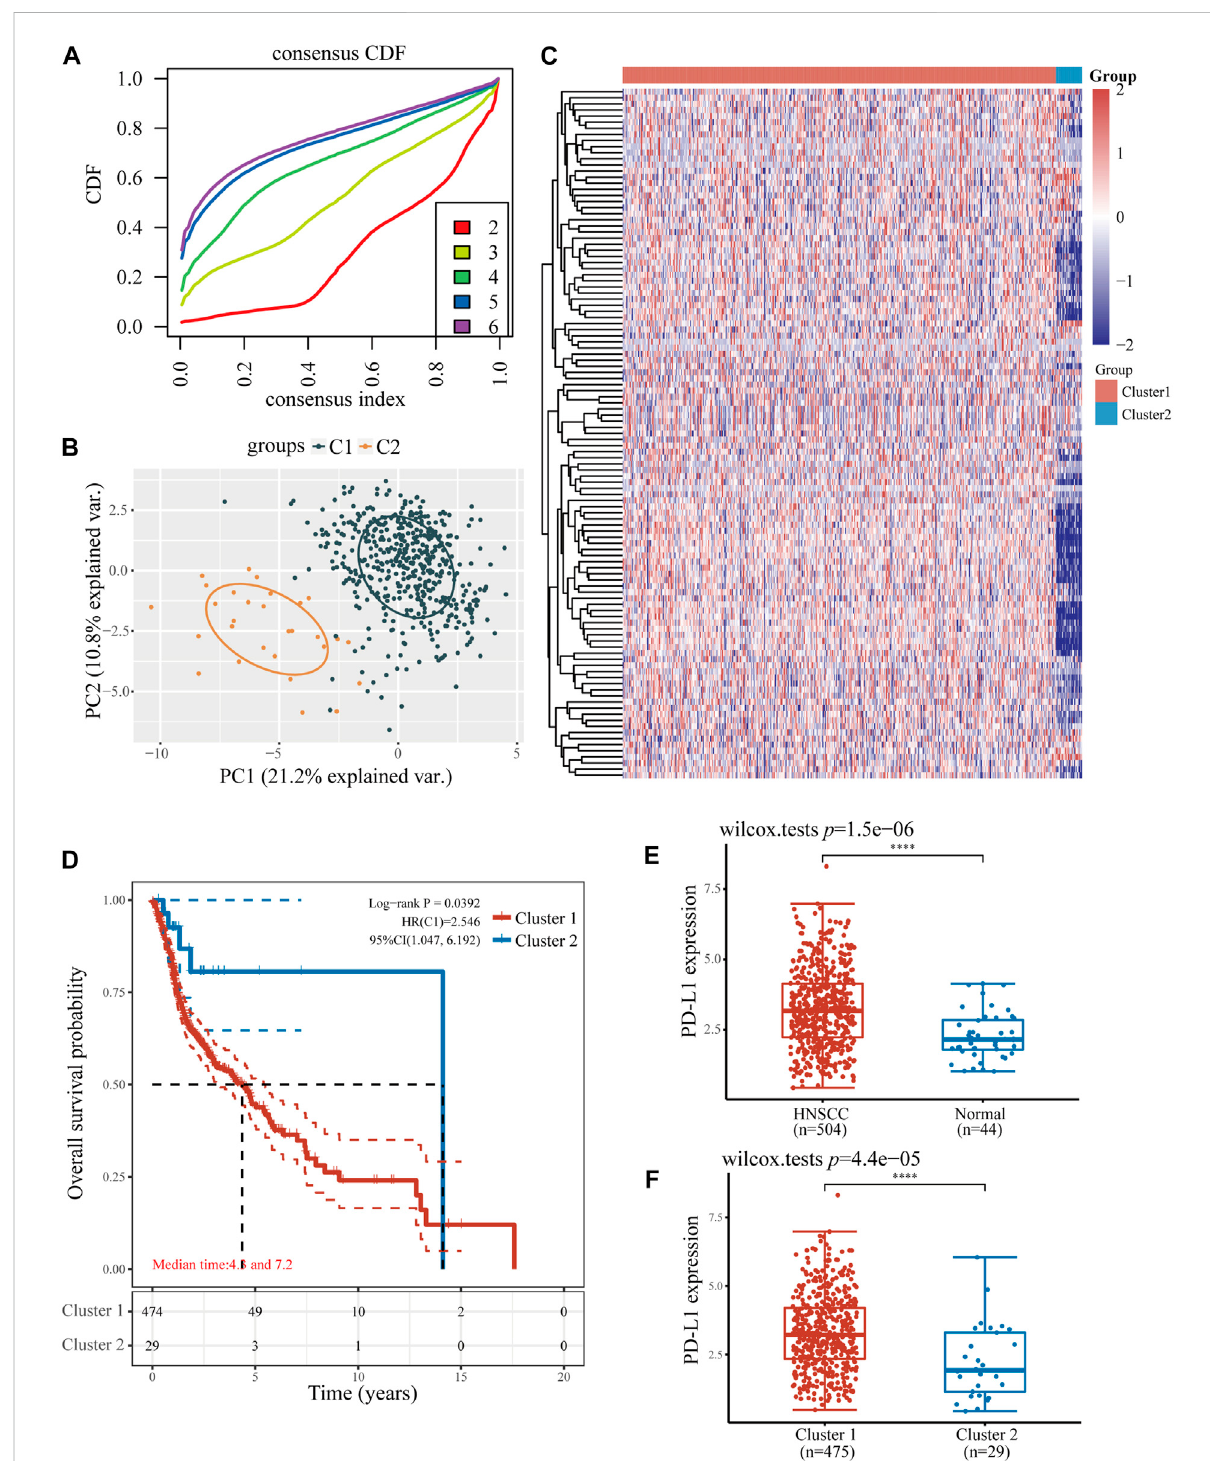
FIGURE 2 The relationship between ferroptosis-related genes and immune cell in fi ltration in two HNSCC subtypes. (A) The consensus clustering cumulative distribution function curves for k = 2 – 6. (B) The PCA of two HNSCC clusters. (C) The consistency of clustering results heatmap ( k = 2), rowsandcolumnsrepresentsamples,thedifferentcolorsrepresentdifferenttypes. (D) TheKaplan – Meiersurvivalanalysisoftwoclustersofsamples fromTCGAHNSCCdataset. (E) TheexpressionlevelofPD-L1inHNSCCandnormalsamples. (F)